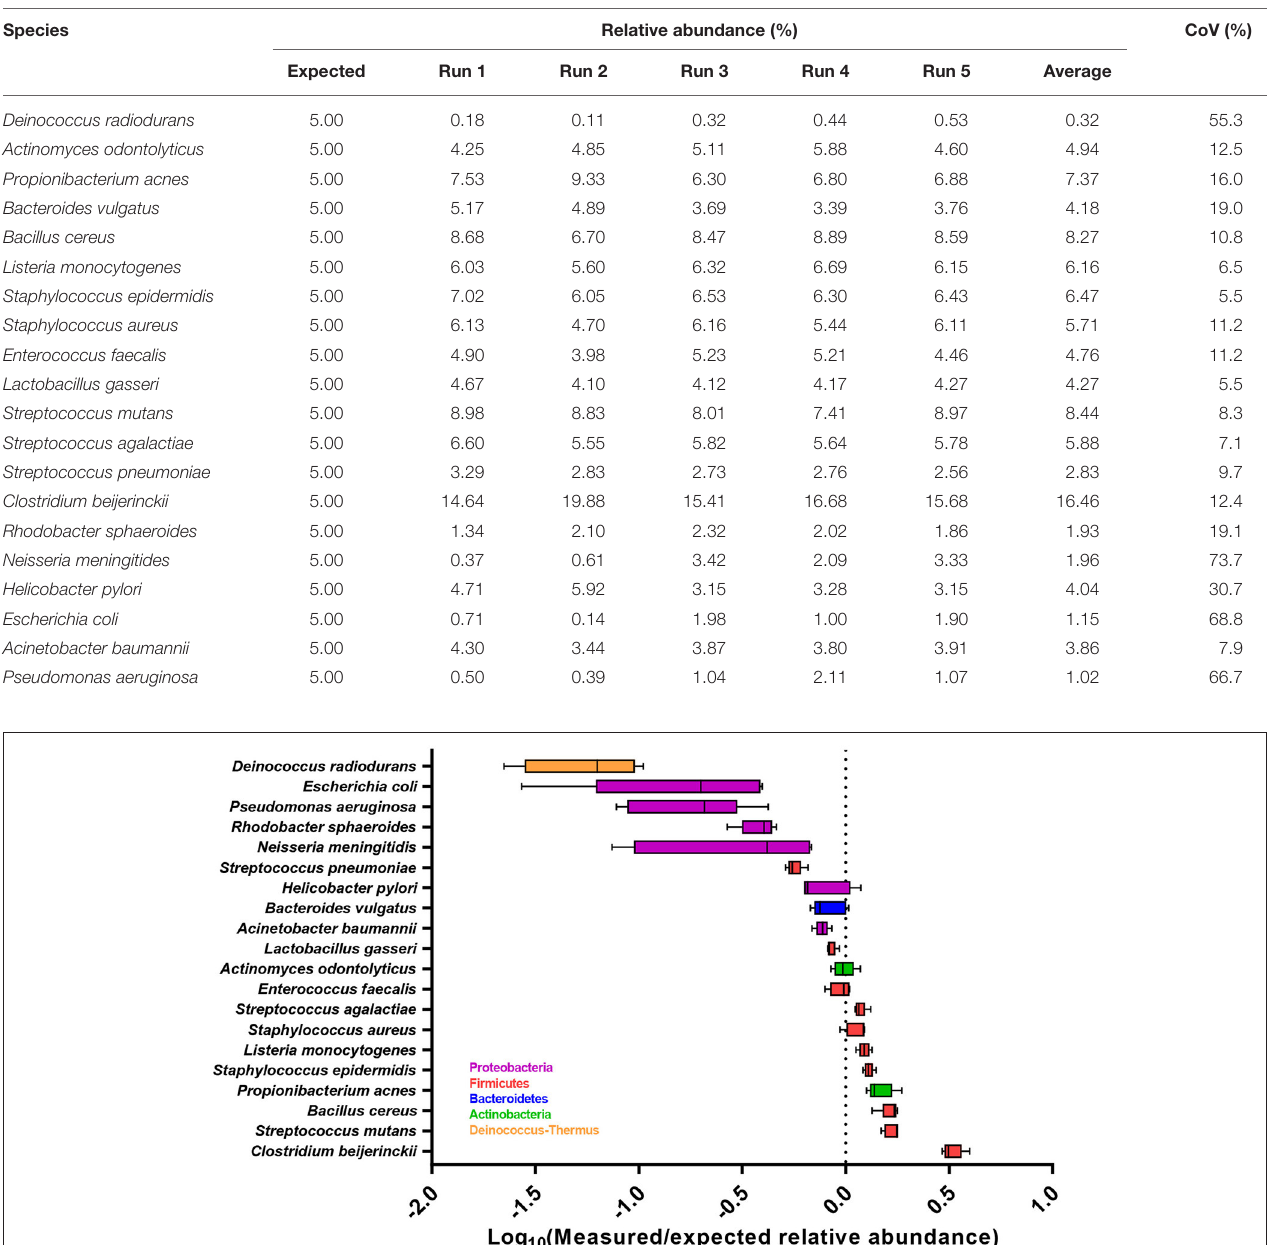
TABLE 3 | Relative abundance estimates of the 20 species in the mock community in 5 separate runs and on average with coefficient of variation. Species